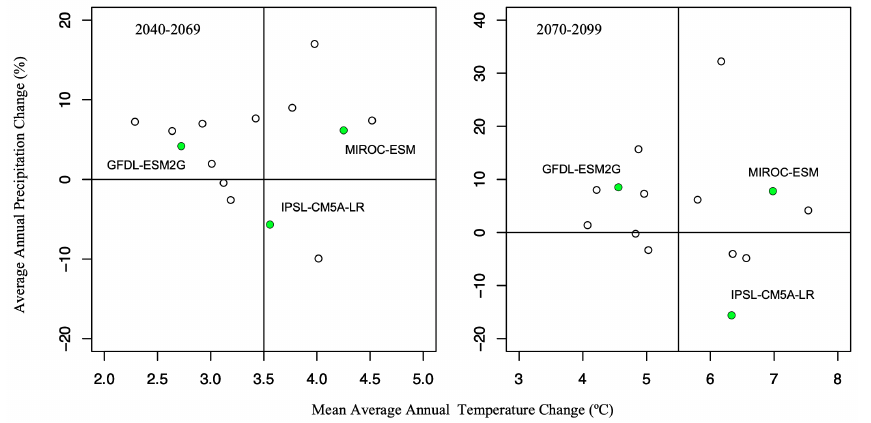
Figure 3. Annual average range of temperature in ◦ C and precipitation in percentage values for two time periods for the three ESM selected for study calculated based on the difference from the historical period (1970–1999).